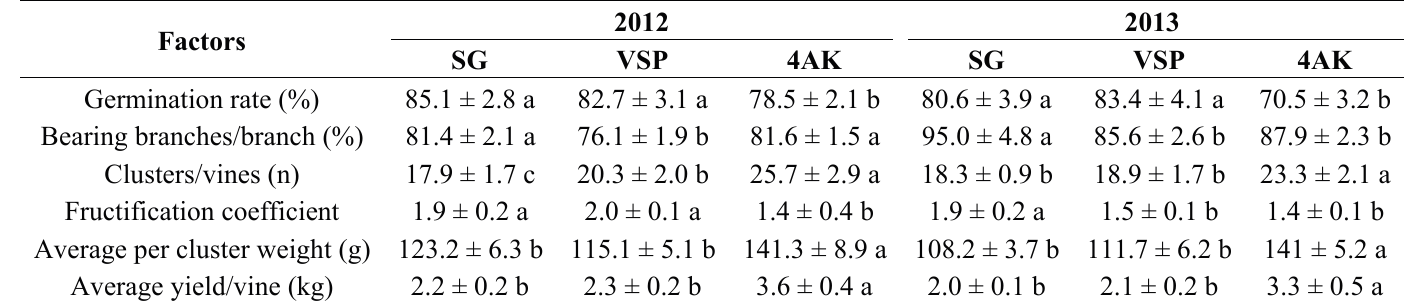
Data represent mean value ±SD for three replicates. Different letters within a row for the same year indicate significant differences between treatments calculated by Duncan’s test ( p <